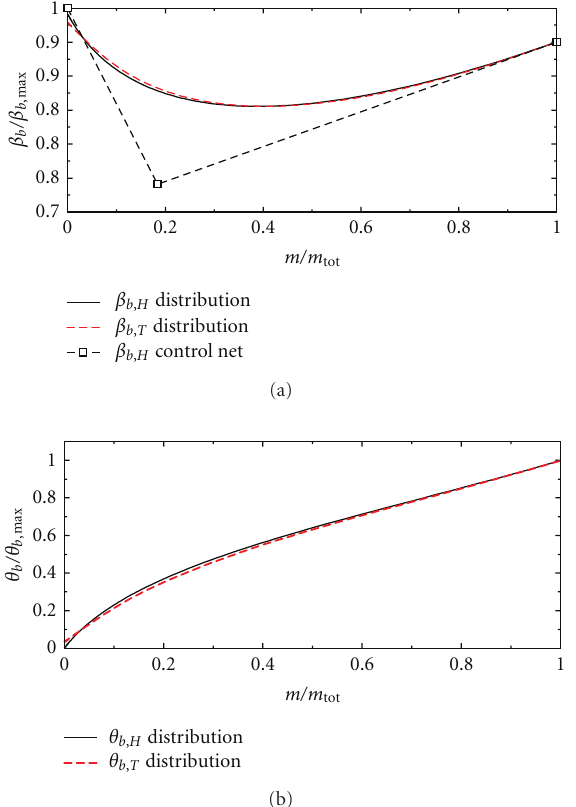
Figure 3: β b angle parameterization and corresponding θ b angles at hub and tip.